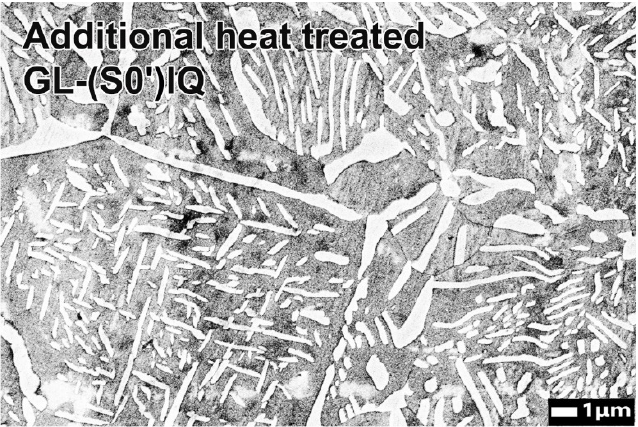
Figure 5. Microstructure of additional heat-treated GL-(S0 ′ )IQ (5000×).